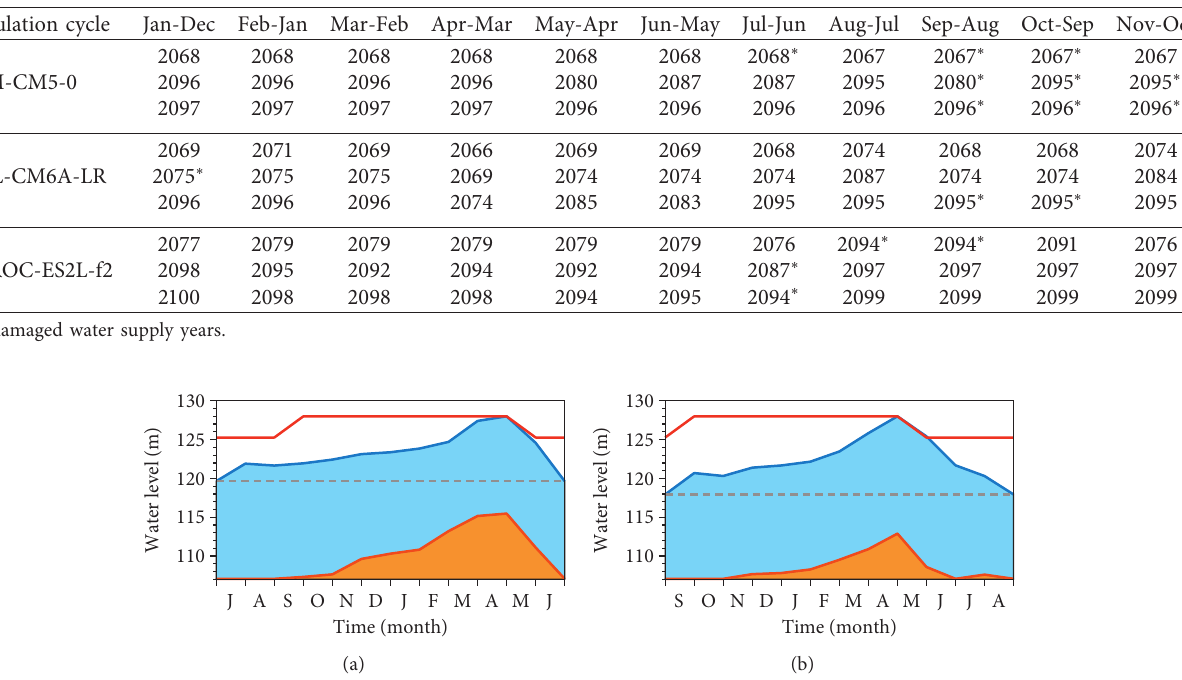
Figure 9: Reservoir rule curves for the July-June scheme (a) and September-August scheme in SSP370 scenario from 2061 to 2100. The red line is the flood limited curve. The blue/orange line is the lower/limited water supply curve. The gray dash line indicates the threshold of annual and carryover